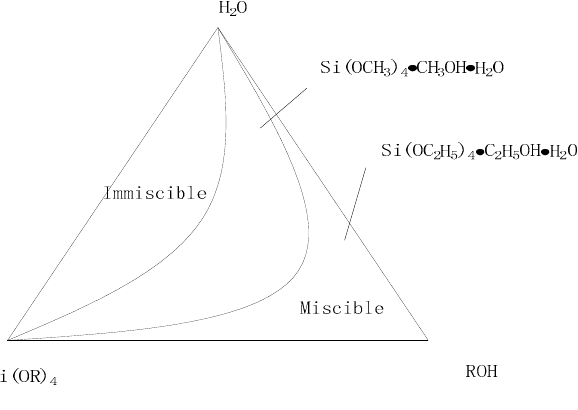
Figure 1. Ternary miscibility diagram.